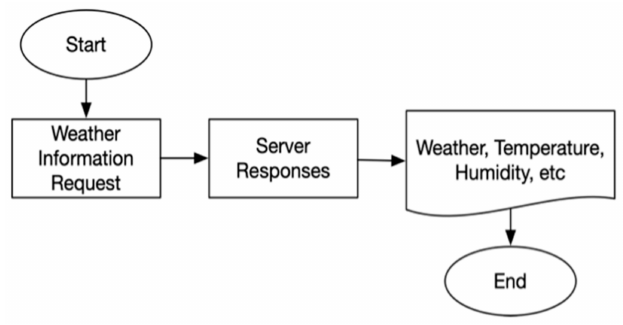
Figure 11. The process of weather information